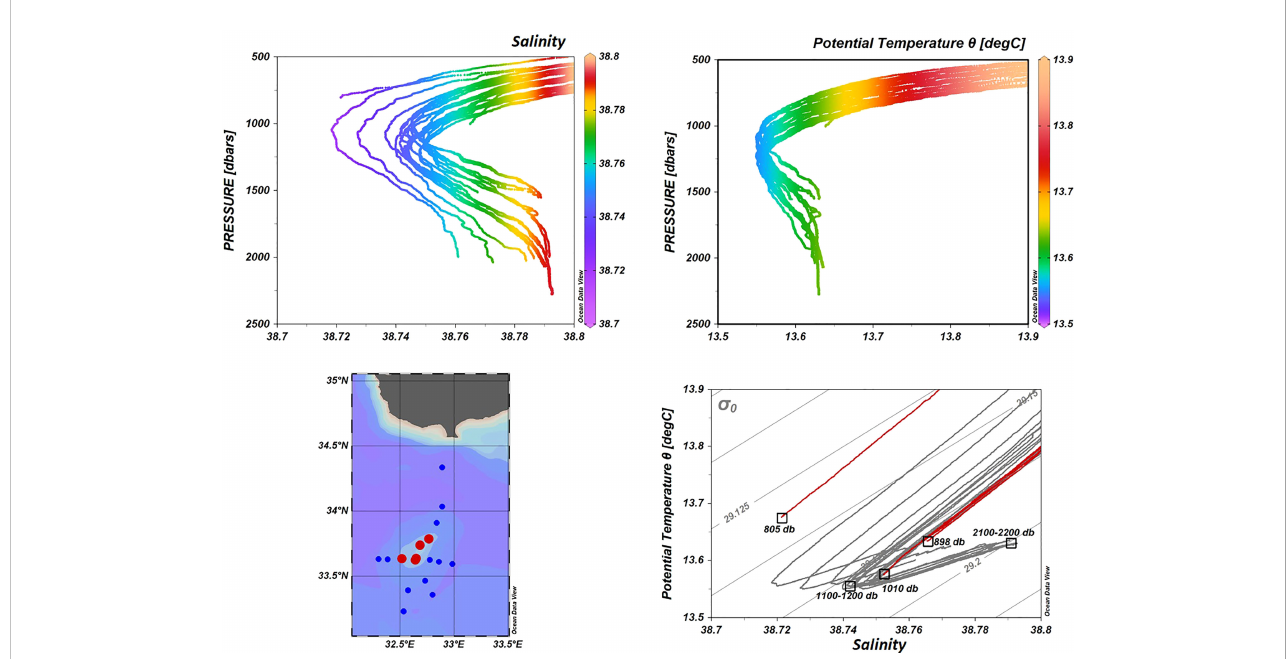
FIGURE 11 The EMTW salinity (upper left) and temperature (upper right) pro fi les and the T/S diagram (lower right) during the MSM14-1 cruise, Dec. 2009- Jan. 2010. Pro fi les and the T/S diagram include only stations sampled deeper than 1000 m where the bottom depth was about 2000 m. Red dots on the map and red lines on the T/S diagram represent the stations over the Eratosthenes SM where the bottom depth is shallower than 1000